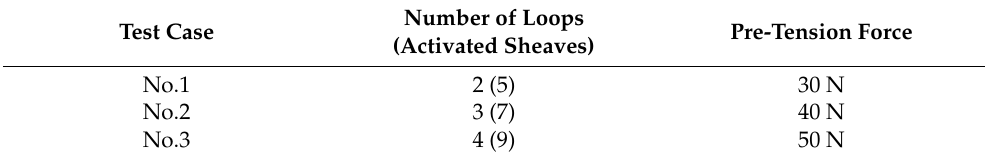
Table 1. Information on the friction